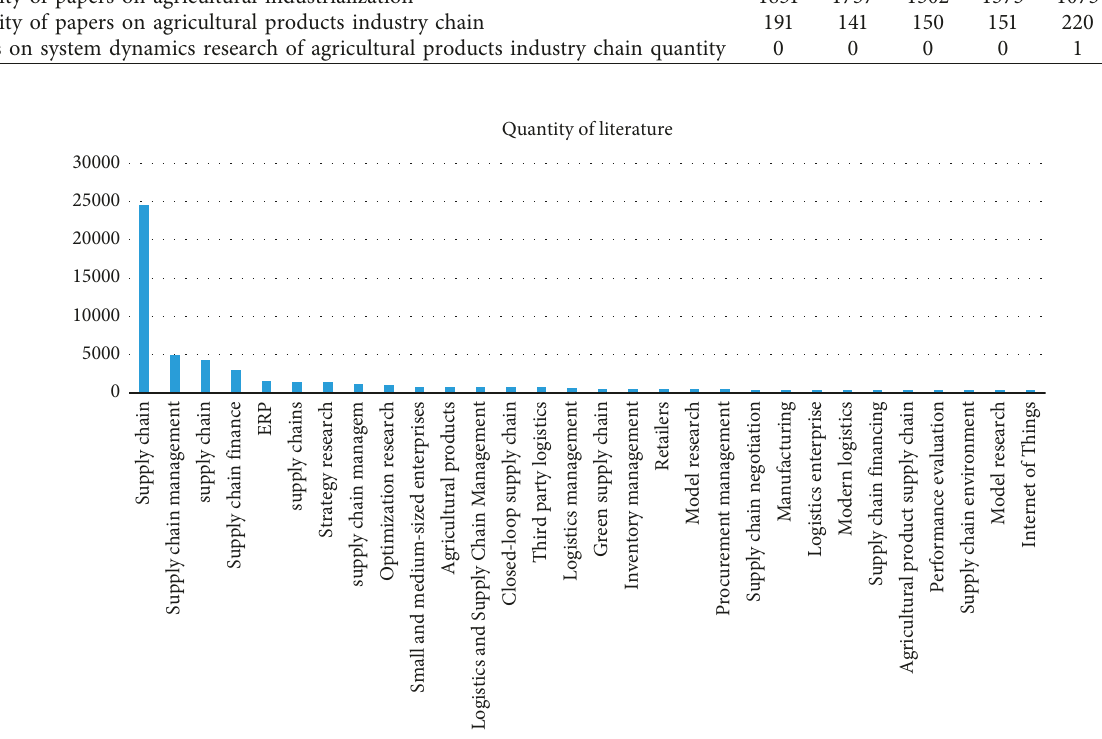
Figure 1: Bar statistical chart of literature quantity.